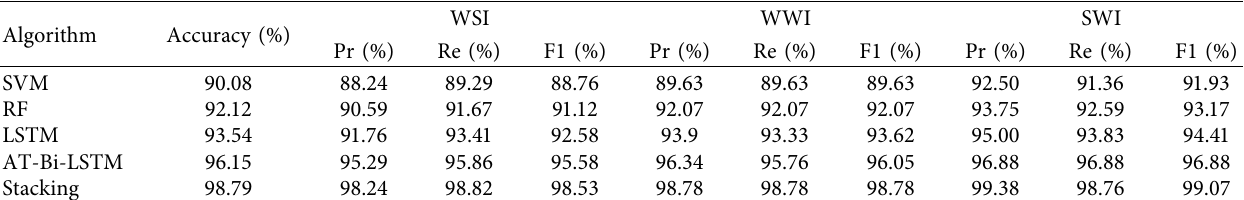
Table 3: Model evaluation result at 0s before crossing the zebra crossing.